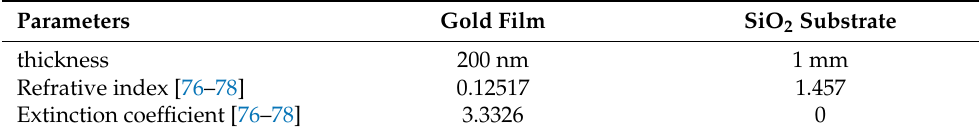
Table 2. Parameters of materials.